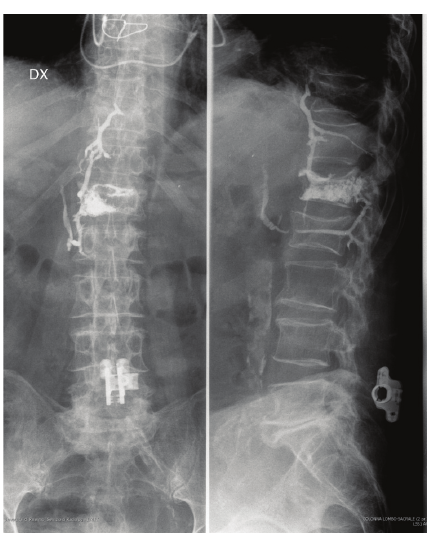
Figure 1: Cement leakage into the Batson’s paravertebral venous system.